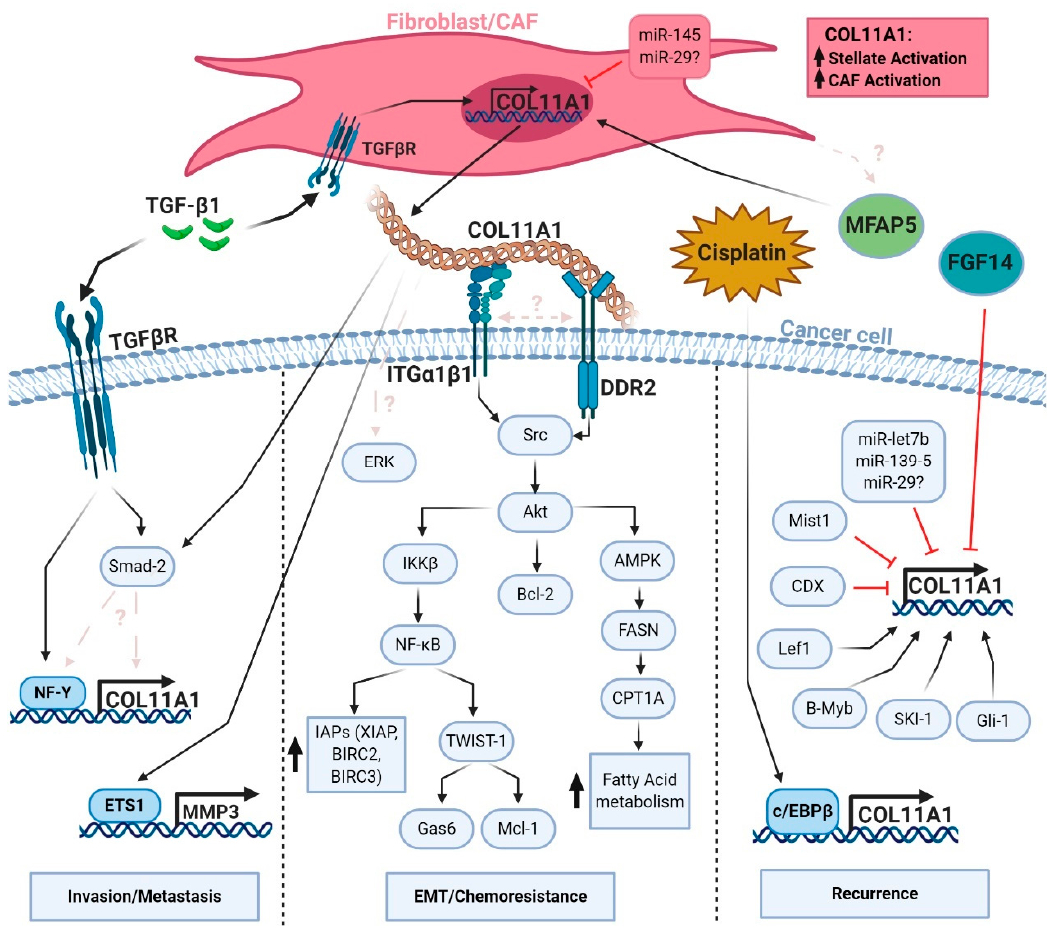
Figure 2. Regulation of COL11A1 signaling in cancer.